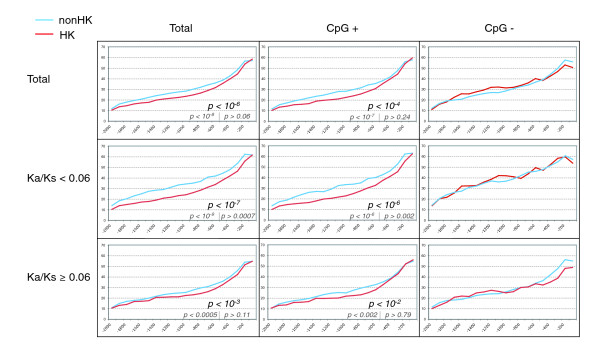
Promoter sequence conservation in HK and non-HK genes. The x-axis shows 100 nucleotide bins along 2 Kb upstream of the TSS. The y-axis shows percent conservation ((1 - dSM) × 100). Genes were grouped according to the presence or absence of a CpG island and Ka/Ks values. Significant p values for 2 Kb promoter sequence divergence comparisons are indicated below the curves. Beneath these, the p values obtained for regions -2,000 to -500 (left), and -500 to the TSS (right), are given in smaller font size.